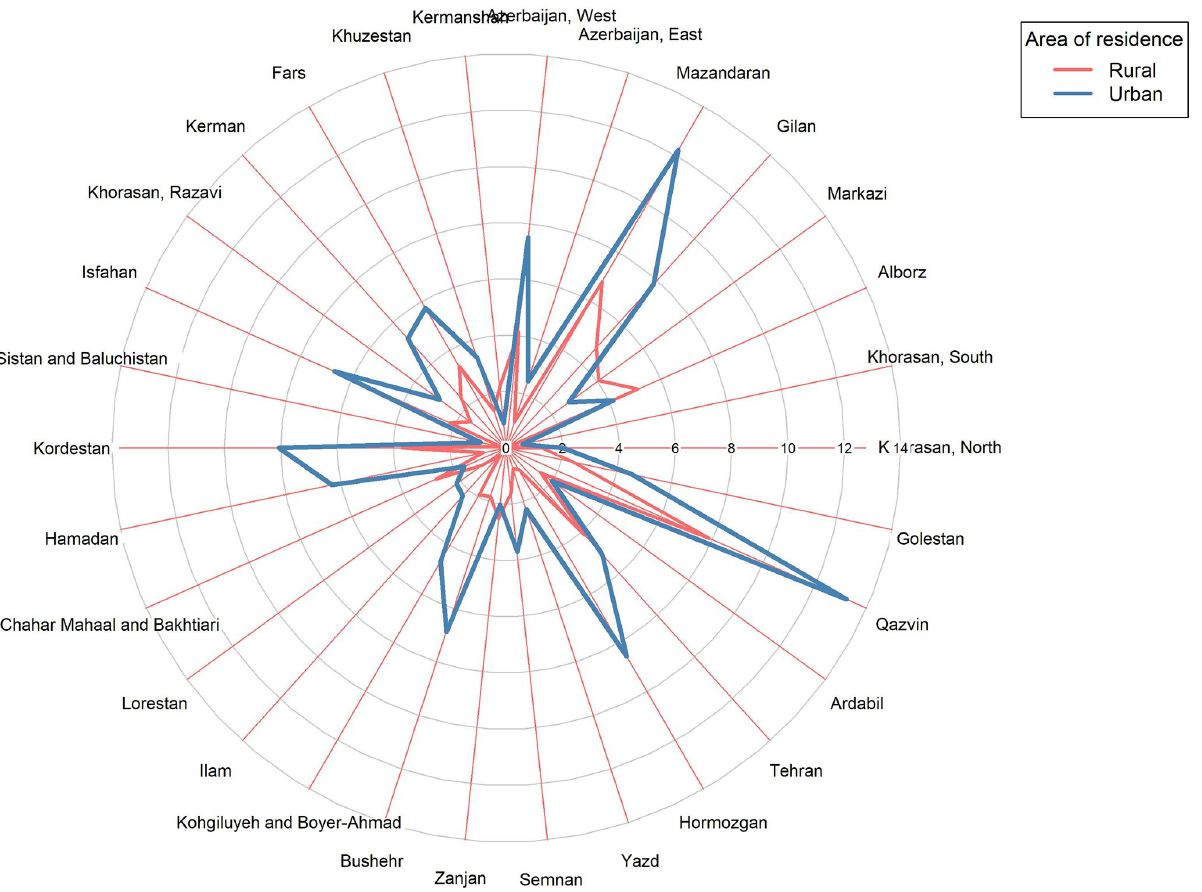
Fig 3. Provincial distribution of alcohol drinking (%) within the past